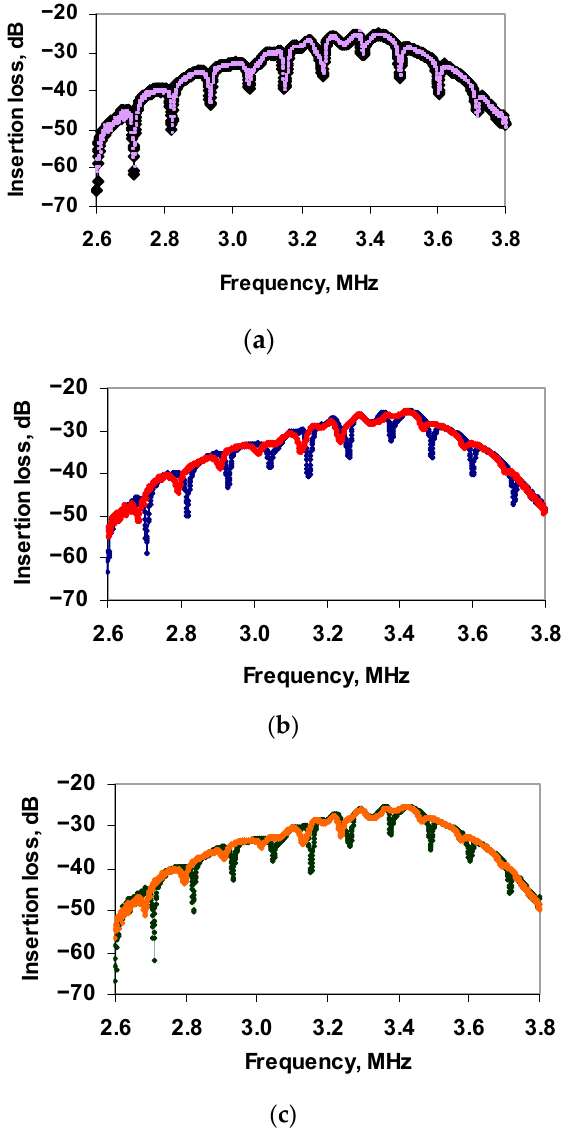
Figure 10. Frequency dependences of the insertion loss of the sensor for buffer solution: ( a ) suspension with M13K07 before (black curve) and after (purple curve) adding Ab TGEV , ( b )suspension with TGE virus before (blue curve) and after (red curve) adding Ab TGEV , ( c ) suspension with TGE virus and M13K07 before (green curve) and after (orange curve) adding Ab TGEV . For comparison, Table 2 shows the data obtained during registration of the effect of Ab TGEV on M13K07, TGE virus and mixed suspension (TGE virus and M13K07) in the buffer solutions with conductivity of 4.1, 50 and 100 μ S/cm. Table 2. Change in the depth of the resonant peak near the frequency of 2.82 MHz due to the addition of the antibodies Scheme 13. K07, the suspension of TGE virus and the mixed suspension (TGE virus and M13K07) at the various values of the conductivity of the buffer solution. Conductivity of Solution, μ S/cm